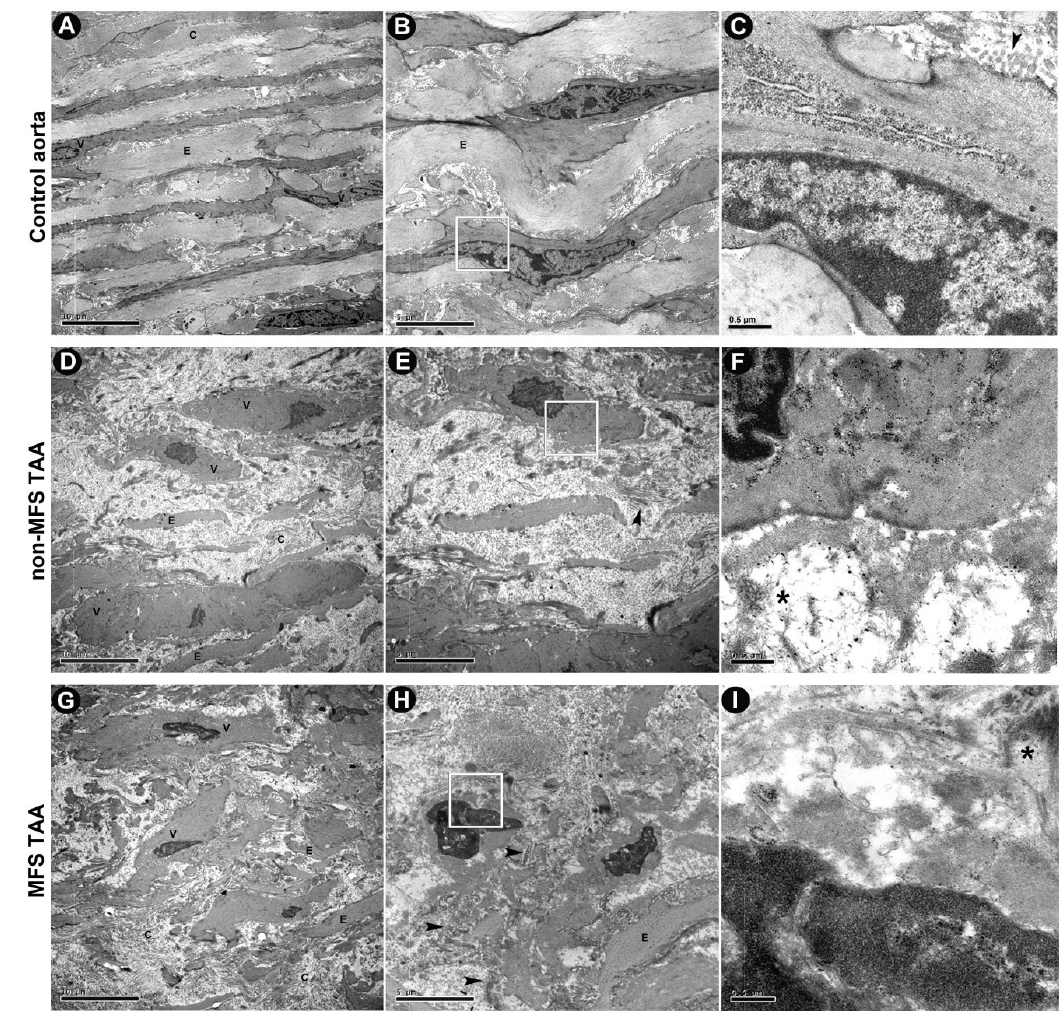
Figure 4. Ultrastructural investigation displays more severe extracellular matrix (ECM) degeneration and smooth muscle cell (SMC) morphological changes in MFS TAA. ( A ) Representative ultrastructural images by TEM show regular SMCs (V) and dense elastin fibers (E) and homogeneous extracellular matrix distribution in the tunica media of control aorta, with normal collagen fibers (C) either extended or twisted in longitudinal sections. ( B , C ) At higher magnification, regularly arranged cytoplasmic microfilaments and a more typical nuclear shape of SMCs are shown. Edematous and loose ECM, irregular fragments and damaged elastin fibers are evident in tunica media of both non-MFS ( D – F ) and MFS TAA ( G – I ). However, the latter shows a worse degenerative pattern of the tunica media, with more electron-dense sparse bundles of disorganized collagen fibrils (arrowheads), as well as thin fibrils sometimes in clusters (*). ( A , D , G) = scale bars equal to 10 µ m; ( B , E , H ) = scale bars equal to 5 µ m; ( C , F , I ) = scale bars equal to 0.5 µ